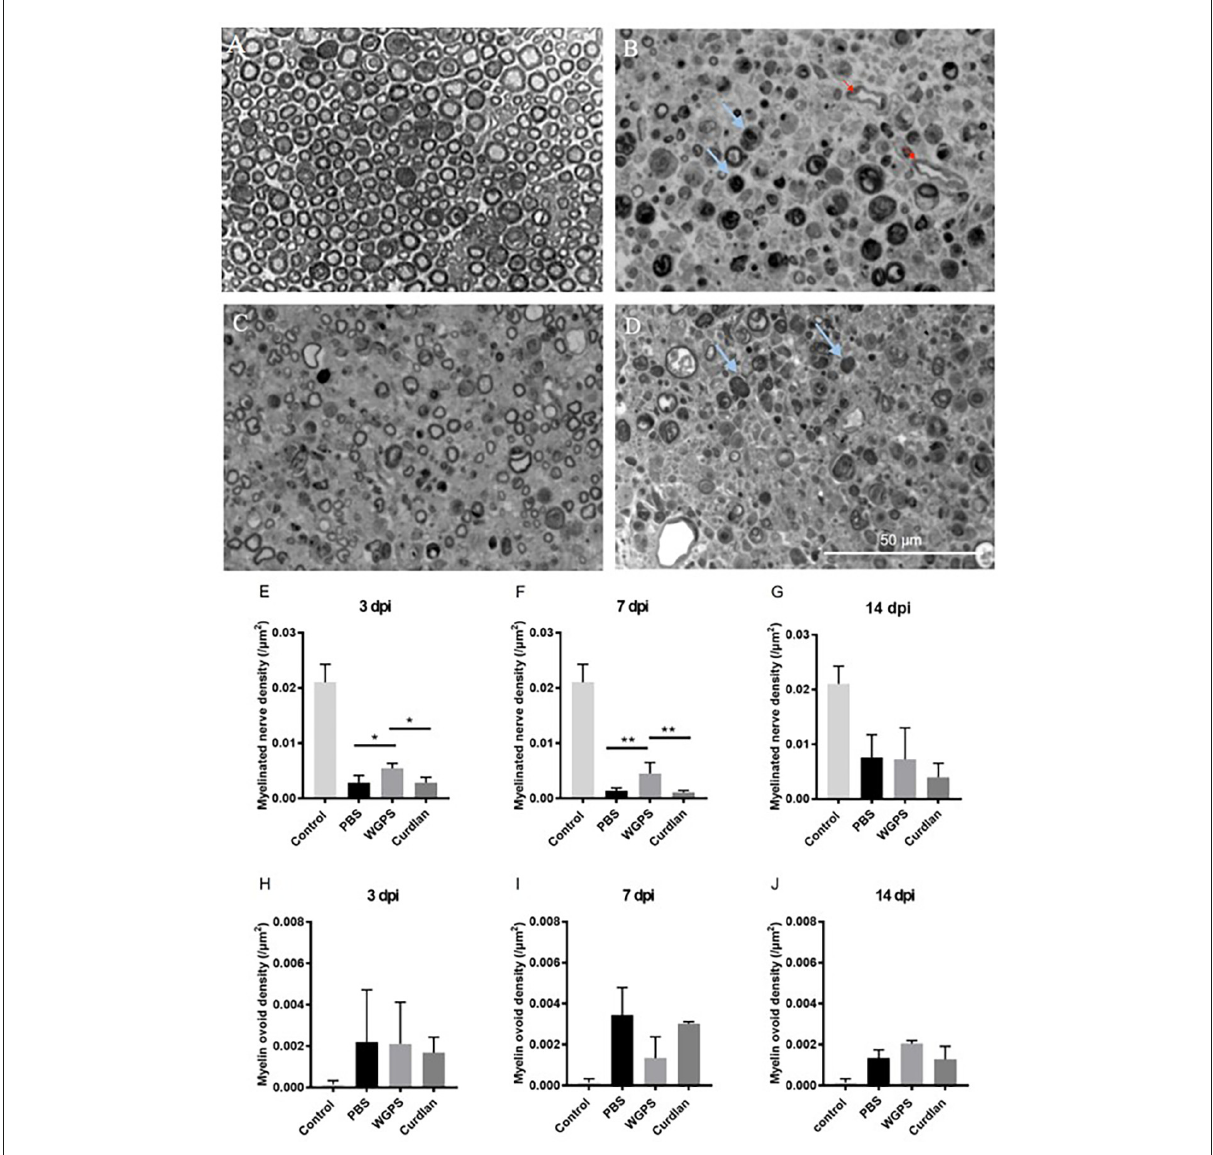
FIGURE5 Semi-thin section morphometry analysis of myelinated nerve and myelin ovoid. Semi-thin cross-sections 1 µ m in thickness of the crushed and injected sciatic nerve distal to injury were stained with toluidine blue for morphometry analysis. The representative figures are from: (A) intact sciatic nerve of sham surgery (contralateral), (B) crushing injury plus PBS injection 7 days after injury (ipsilateral), (C) crushing injury plus WGPS injection 7 days after injury (ipsilateral) and (D) crushing injury plus curdlan injection 7 days after injury (ipsilateral). Quantitative analysis of myelinated nerve density is shown in (E–G) . Quantitative analysis of myelin ovoid density is shown in (H–J) . (A) Most myelinated nerves were intact on the sham surgery (contralateral) side. (B–D) There were fewer intact myelinated nerves, more blood vessels (red arrows), and a trend of more myelin ovoid (blue arrows; p = 0.06) 7 days after injury. (E) In the PBS and curdlan injected groups, there were fewer intact myelinated nerves 3 days after injury. Data are expressed as mean ± SD ( n : control n = 7, 3 dpi: PBS n = 4, WGPS n = 3, curdlan n = 4; 7 dpi: PBS n = 6, WGPS n = 3, curdlan n = 3; 14 dpi: PBS n = 3, WGPS n = 3, curdlan n = 3), * p < 0.05. dpi, day post-injury. Data obtained from the sham surgery (contralateral) side was denoted as “control” in this figure. ** p <